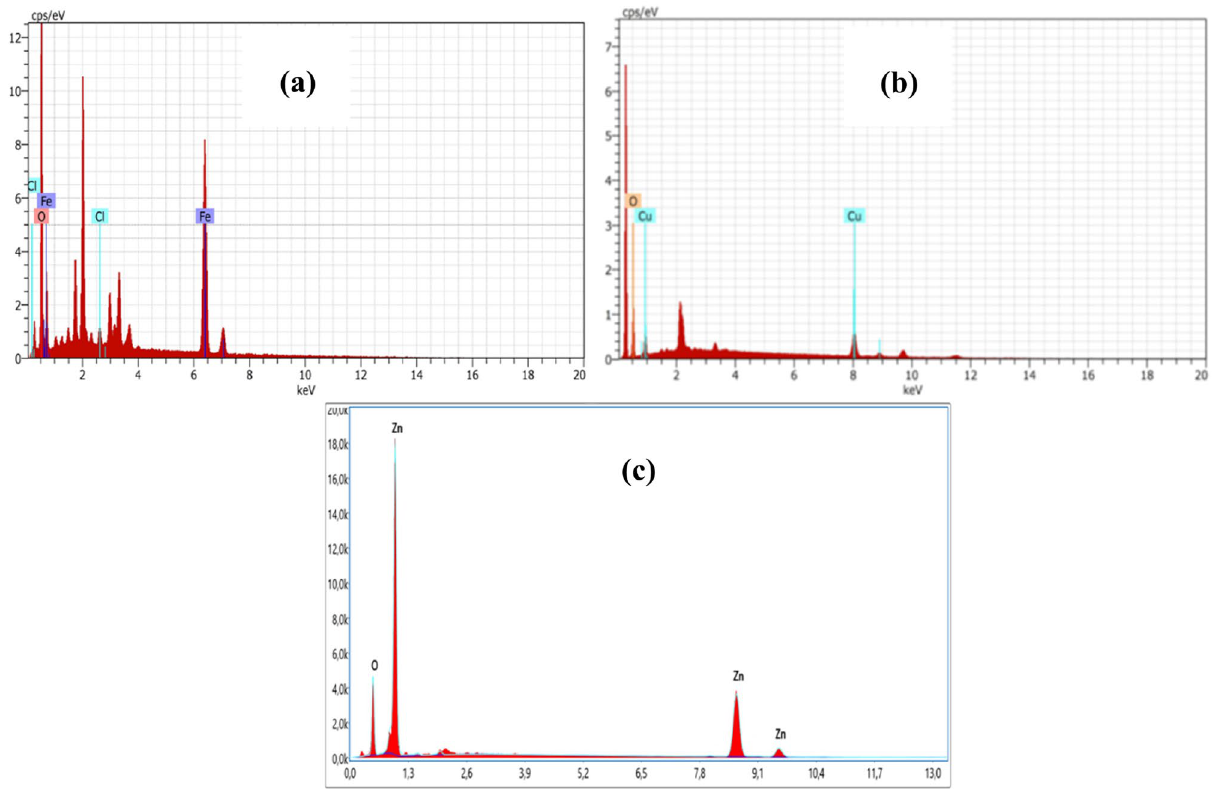
Figure 4. EDS of ( a ) α-Fe 2 O 3 ,( b ) CuO,( c ) and ZnO Nanoparticles.